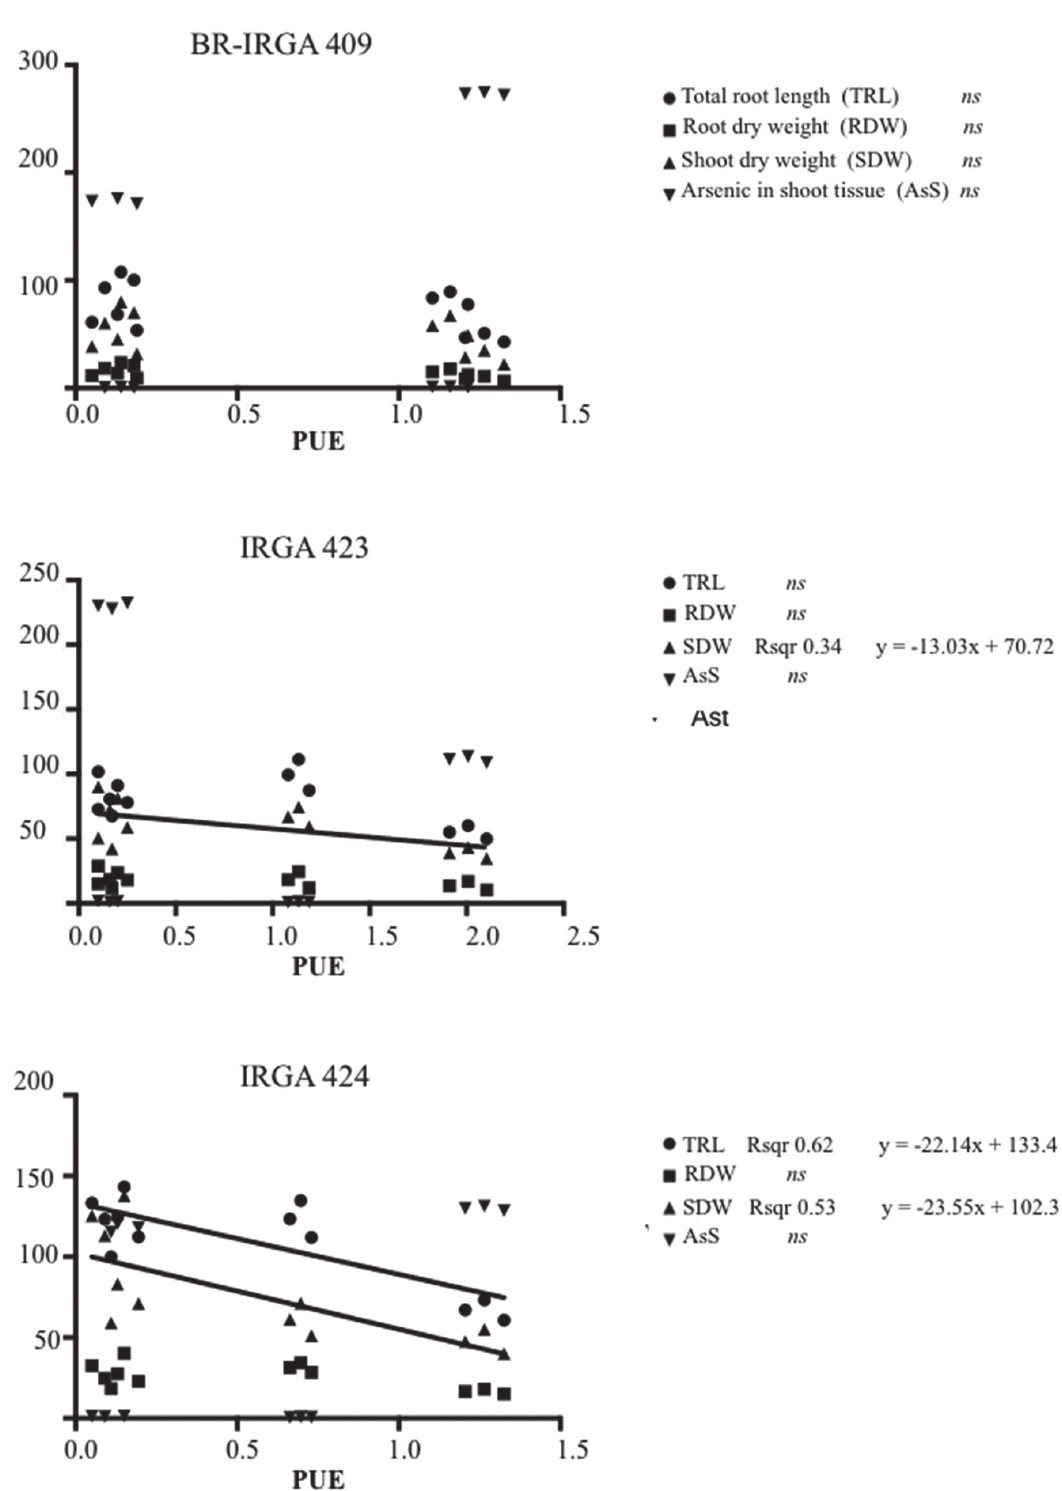
Figure 6 - Phosphorus use efficiency (PUE) relationship to sum of species of total As, shoot dry weight, root dry weight and total root length for BR-IRGA 409, IRGA 423 and IRGA 424 cultivars in shoot tissue